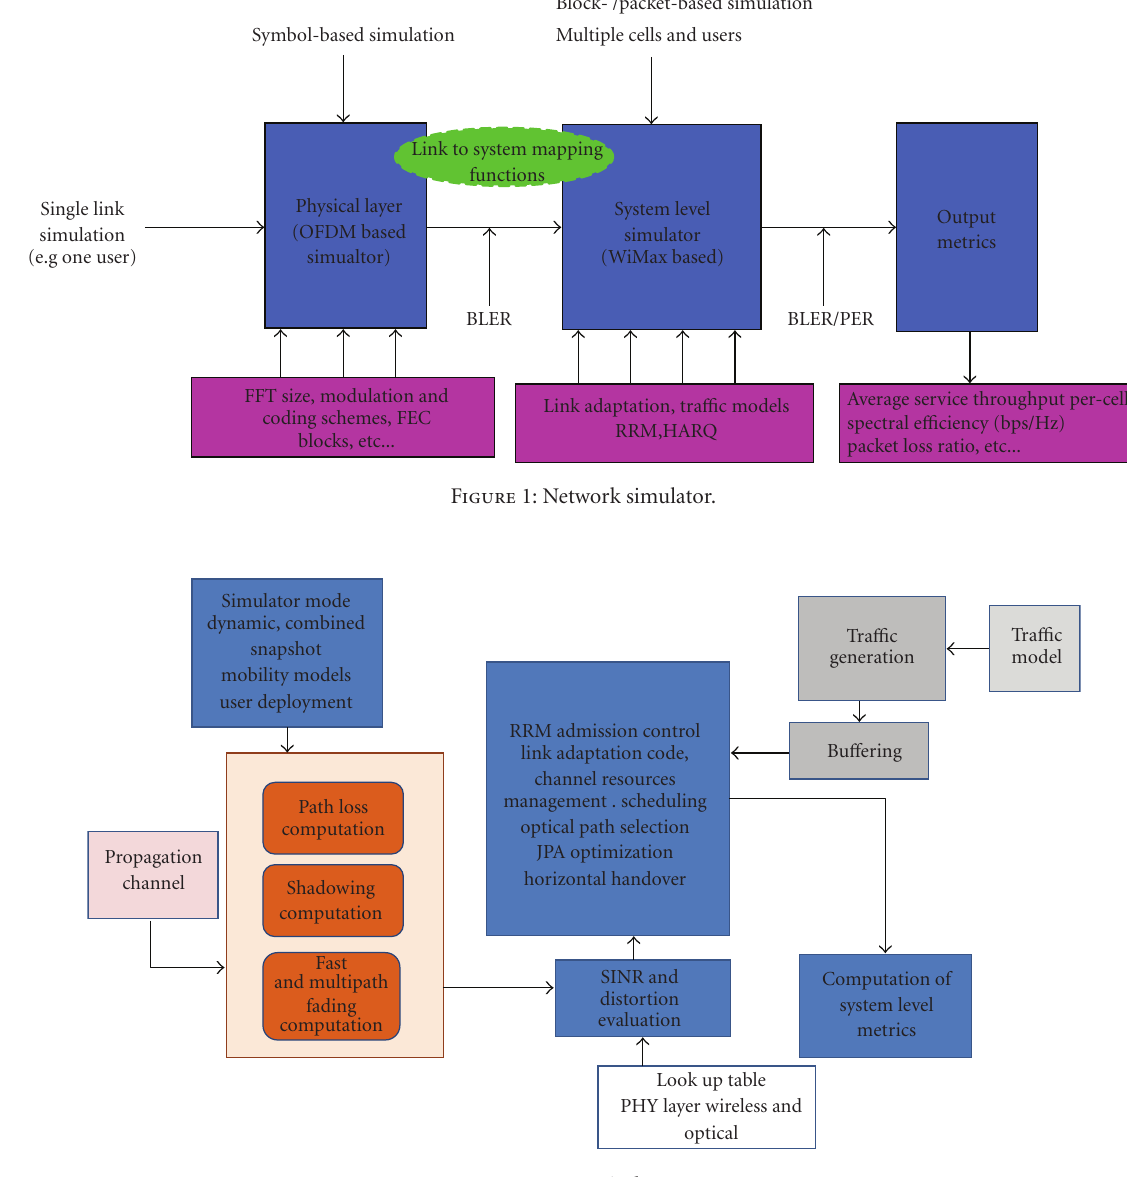
Figure 2: Logical